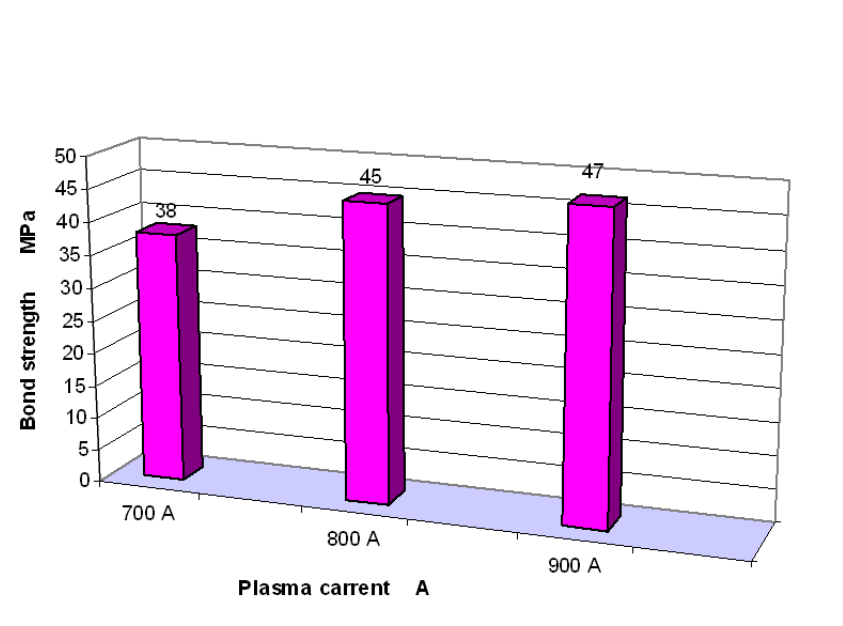
Figure 3 – Results of the bond strength of Al 2 O 3 coatings Рис . 3 – Результаты твердости связи покрытия Al 2 O 3 Слика 3 – Резултати чврстоће споја превлака Al 2 O